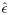
Simulation of catastrophic forgetting, Ribot gradients, and the spacing effect.
A, Networks without structural plasticity suffer from catastrophic forgetting (top), but networks with structural plasticity do not (bottom). Plots show output noise ϵ^ over time t simulating networks of size n = 1000 and activity k = 50 storing 25 memory blocks one after the other (only the interesting part between storage of blocks 6 and 21 are visible). Each curve (with a distinct color) corresponds to ϵ^ for noisy test patterns of a particular memory block with c = 45 correct and f = 5 false active units. The steep descent of each curve corresponds to the time when the Hippocampus started to replay the corresponding memory block for 5 time steps. B, Networks employing structural plasticity show Ribot gradients after a cortical lesion (top) due to gradients in effectual connectivity (bottom). The lesion was simulated by deactivating half of the neurons in population u at time t = 20. C, Networks employing structural plasticity reproduce the spacing effect of learning. In the first simulation (blue) novel memories were rehearsed once for 20 time steps (blue arrow at t = 0−19). In a second simulation (red) the same total rehearsal time was “spaced'' or distributed to four brief intervals of five steps each (red arrows at t = 0−4, t = 100−104, t = 200−204, and t = 300−304). Here the network achieves a higher effectual connectivity P
eff (bottom) and less retrieval noise ϵ (top). See Sections 2, 3 and Table 1 for further details and simulation parameters.